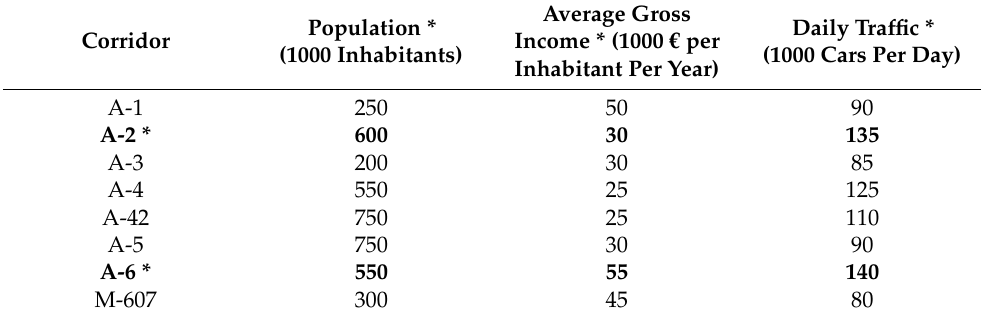
Table 1. Broad characteristics of the eight transport corridors in Madrid Region (rounded values). Average Gross Population * Daily Traffic * Corridor Income * (1000 € per (1000 Inhabitants) (1000 Cars Per Day) Inhabitant Per Year) 250